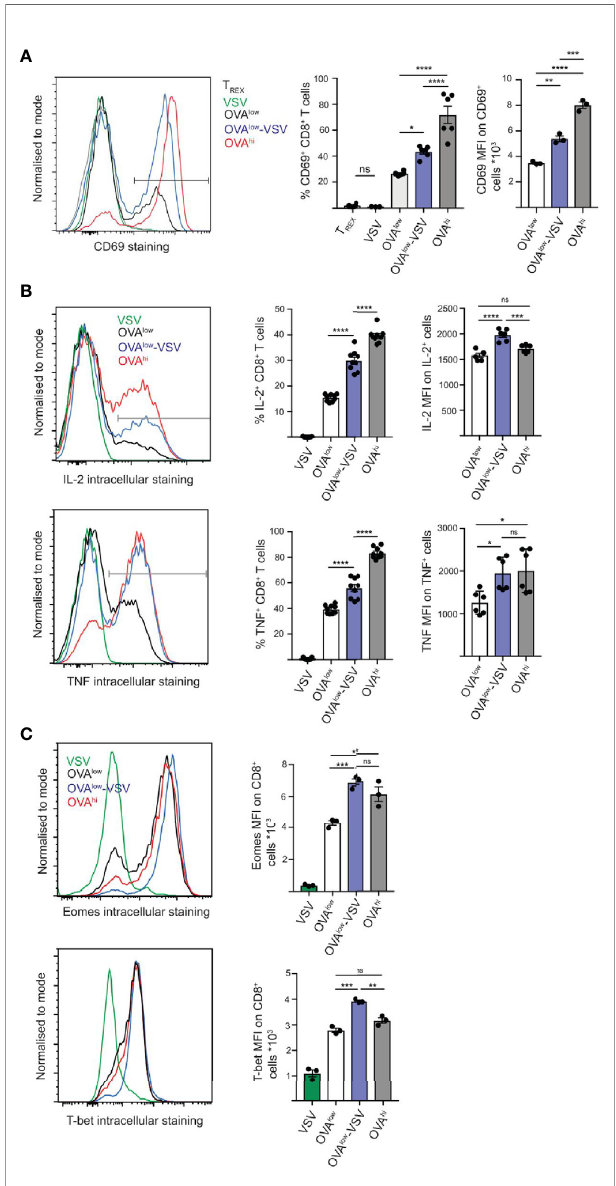
FIGURE 1 | Co-agonism enhances CD8 + T cell activation and transcription factor expression. Ex vivo OT-I lymphocytes were stimulated with the indicated CHO APCs for 3h (A) , 5h (B) or 24h (C) , followed by surface staining to detect CD69 activation marker (A) , or intracellular staining to detect intracellular cytokines (B) or transcription factors (C) on CD8 + T cells. (A) Data from 6 mice from 2 independent experiments (%) or 3 mice from 1 experiment, representative of 2 independent experiments (MFI). (B) Data from 9 mice from 3 independent experiments (%) or 6 mice from 2 experiments (MFI), representative of 3 independent experiments. (C) Data from 3 mice from 1 experiment, representative of 3 independent experiments. Statistical signi fi cance was calculated using one-way ANOVA, with Tukey ’ s multiple comparisons test. *P < 0.05, **P < 0.01, ***P < 0.001, ****P < 0.0001, ns, P ≥